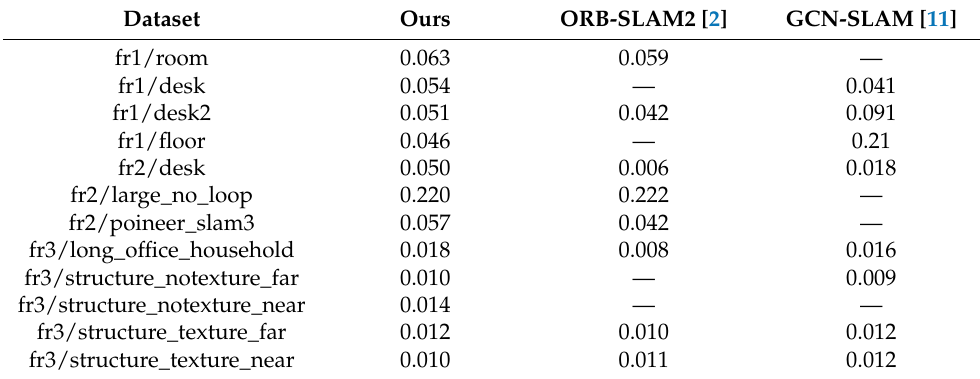
Table 2. Trajectory absolute